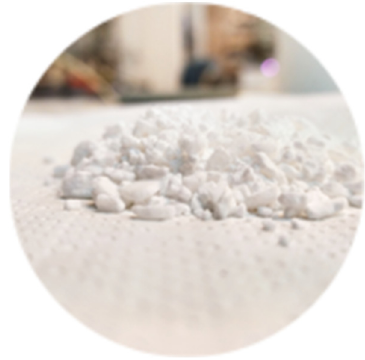
Figure 3. Calcium chloride . Figure 3. Calcium